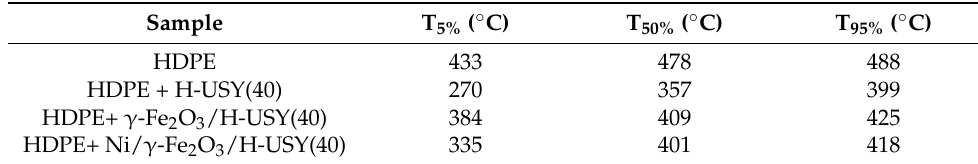
Figure 4. TGA ( a ) and heat flows ( b ) profiles for the catalytic degradation of HDPE under H 2 atmosphere over parent and MNPs impregnated H-USY(40) zeolites. Table 3. Comparison of T5%, T50% and T95% for HDPE degradation on H-USY(15) catalyst at 15%.